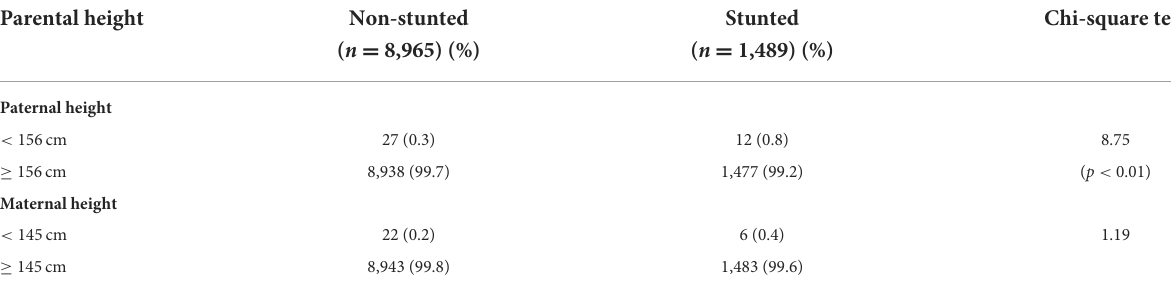
TABLE 3 Comparison between children who were stunted and non-stunted by parental height ( N = 10,454). Parental height Non-stunted Stunted Chi-square